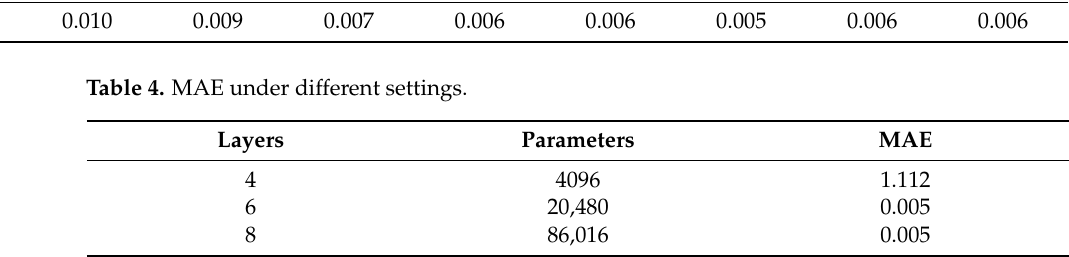
Figure 6. The loss curves of the training and validation sets.